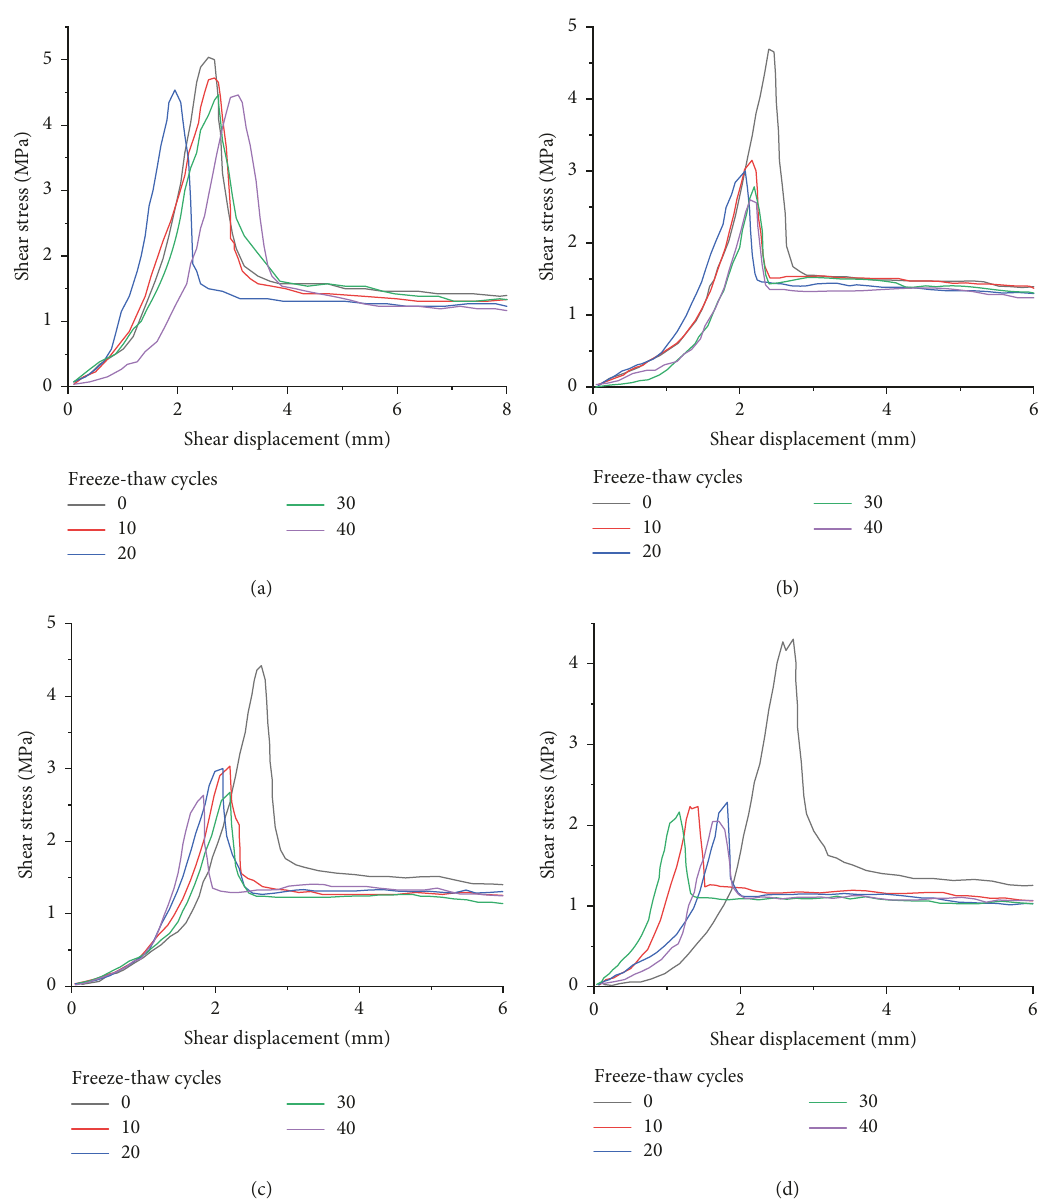
Figure 10: Relationship between shear stress and shear displacement of different freezing-thawing cycles under different persistency. (a) λ � 0, (b) λ � 20%, (c) λ � 30%, and (d) λ �